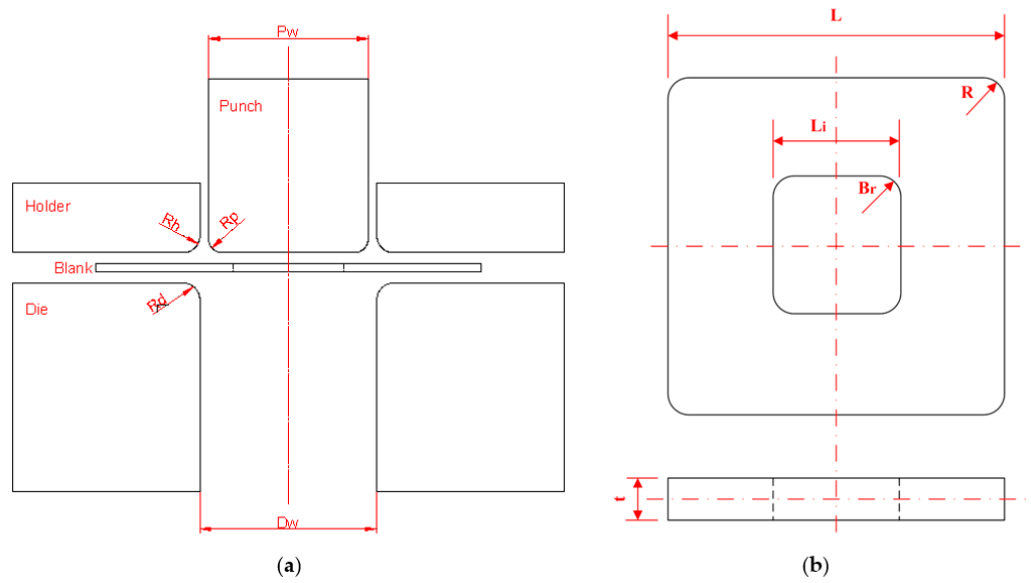
6 of 23 Table 2. Relevant parameters of the flange die. (unit: mm). Model 1 0.30 Table 3. Parameters and dimensions of the flange. (unit: mm). Model 1